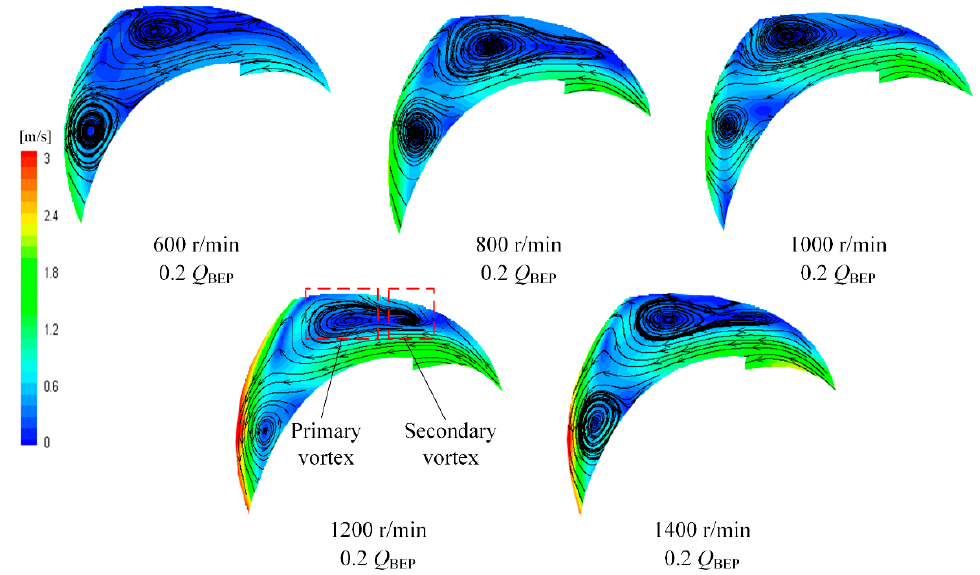
Figure 4. Flow streamlines for the five rotational speeds at the flow rate of 0.2 Q BEP .